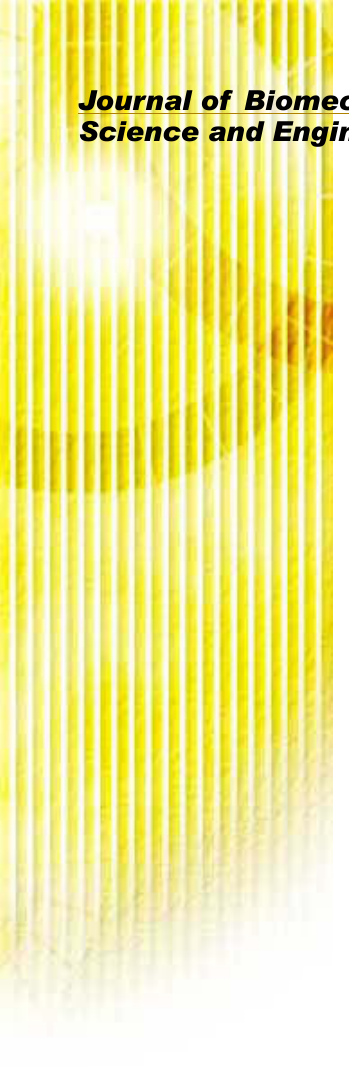
In conclusion, “Rise-to-Peak time” was proposed as an index of probe angle in the clinical ultrasound measurement of articular cartilage. The results showed that the relationship between the “Rise-to-Peak time” and the probe angle for the articular cartilage was similar to those for copper and rubber surfaces. Echo-amplitude correction using the Rise-to-Peak time suppressed the probe-angle derived error, but some correction-derived error could not be negligible under 2 degrees of probe angle in the measurement of Rz = 62 µ m reflection